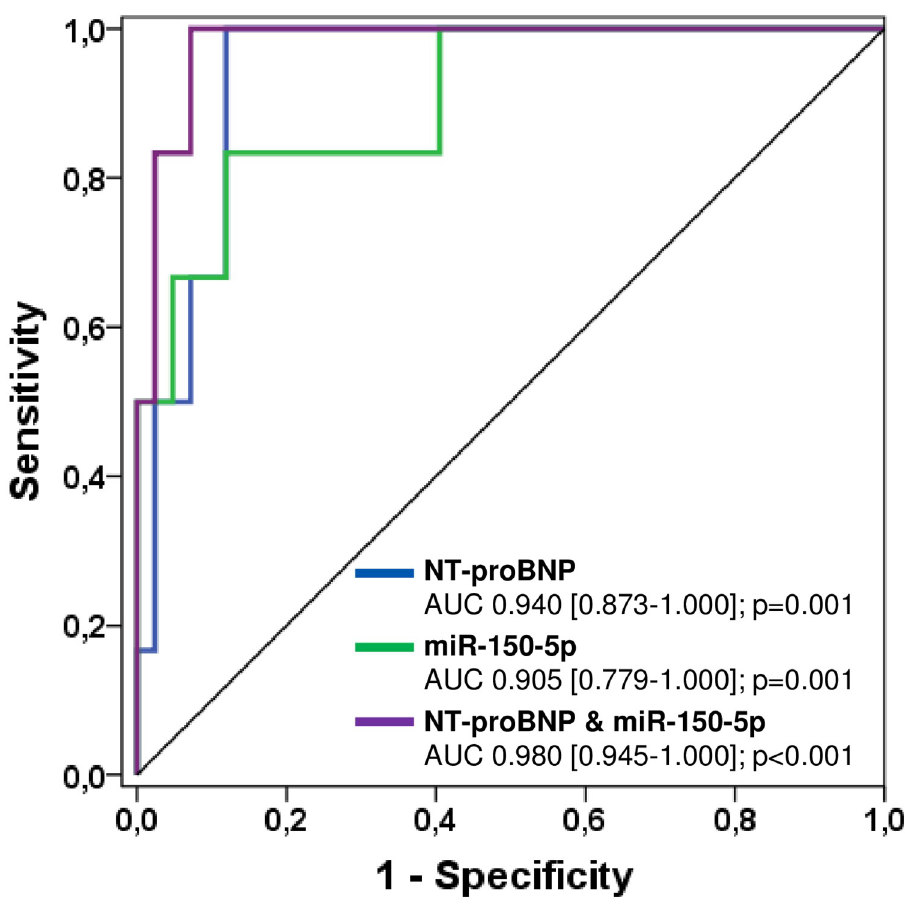
Fig 3. Receiver-operating characteristic (ROC) curves comparing sensitivity and specificity of NT-proBNP and miR-150-5p in predicting overt heart failure. AUC, area under the curve.